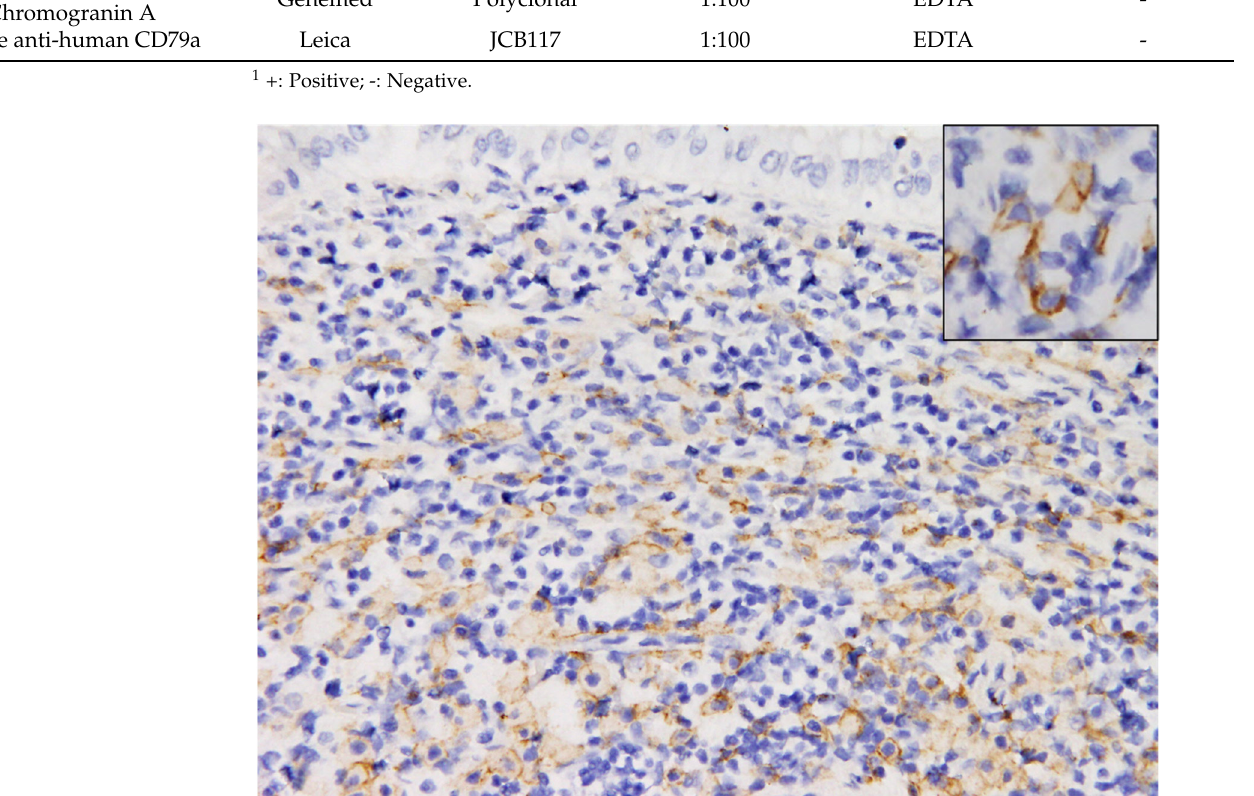
Figure 8. Gastric mast cell tumor (MCT), African dormouse, Immunohistochemistry against KIT. Some of the neoplastic cells reveal strong membranous pattern (400×). The same pattern can also be observed in the normal MMCs (inset) (400×).